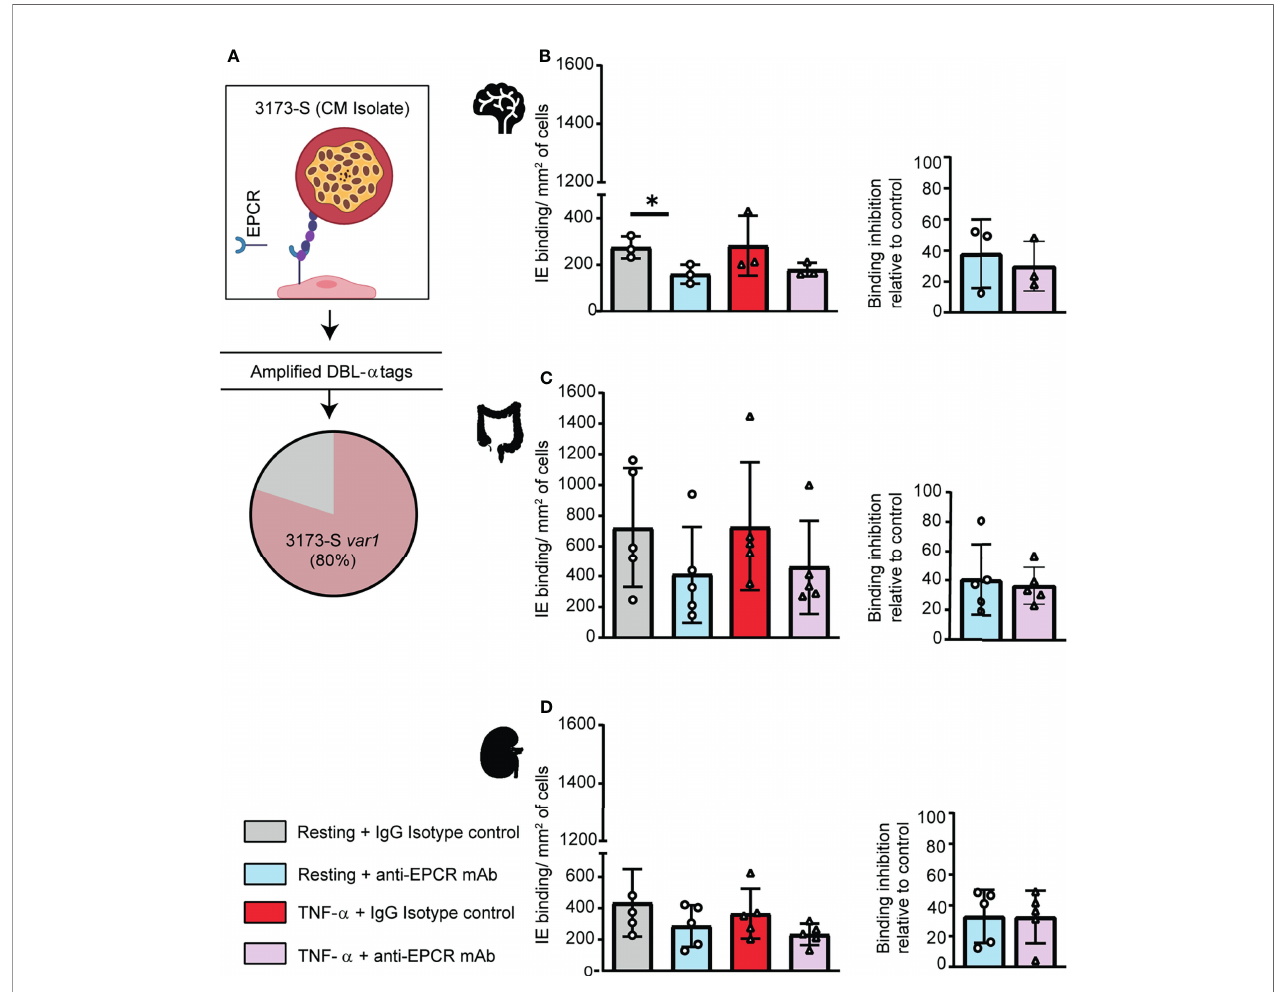
FIGURE 4 | A DC8-PfEMP1 expressing parasite line (3173-S) isolated from a cerebral malaria patient binds to brain, intestinal and kidney endothelial cells . (A) The 3173-S parasite line predominantly expresses the 3173-S var1 transcript (DC8-PfEMP1) based on sequencing of DBL a sequence tags. Binding of 3173-S was compared to primary human microvascular endothelial cells from (B) brain, (C) intestinal, and (D) peritubular kidney endothelial cells. Binding levels were compared on resting and TNF a -stimulated cells in the presence and absence of anti-EPCR antibody. Data are expressed as mean ± SD and were analyzed by unpaired t test. *p<0.05. EPCR: endothelial protein C